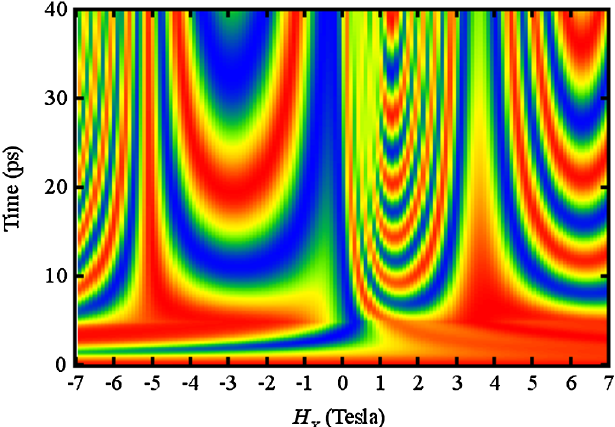
FIG. 7. Switching-phase diagram for Fe set of parameters as indicated in Fig. 3 for the Fe trilayer, except for the IEC, which was set to be equal to zero. In these simulations, the x component to the applied field was varied, whereas the z component was kept constant, H z ¼ 5 T , j K j ¼ 0 : 06 mRy , and (cid:2) ¼ 0 : 02 .